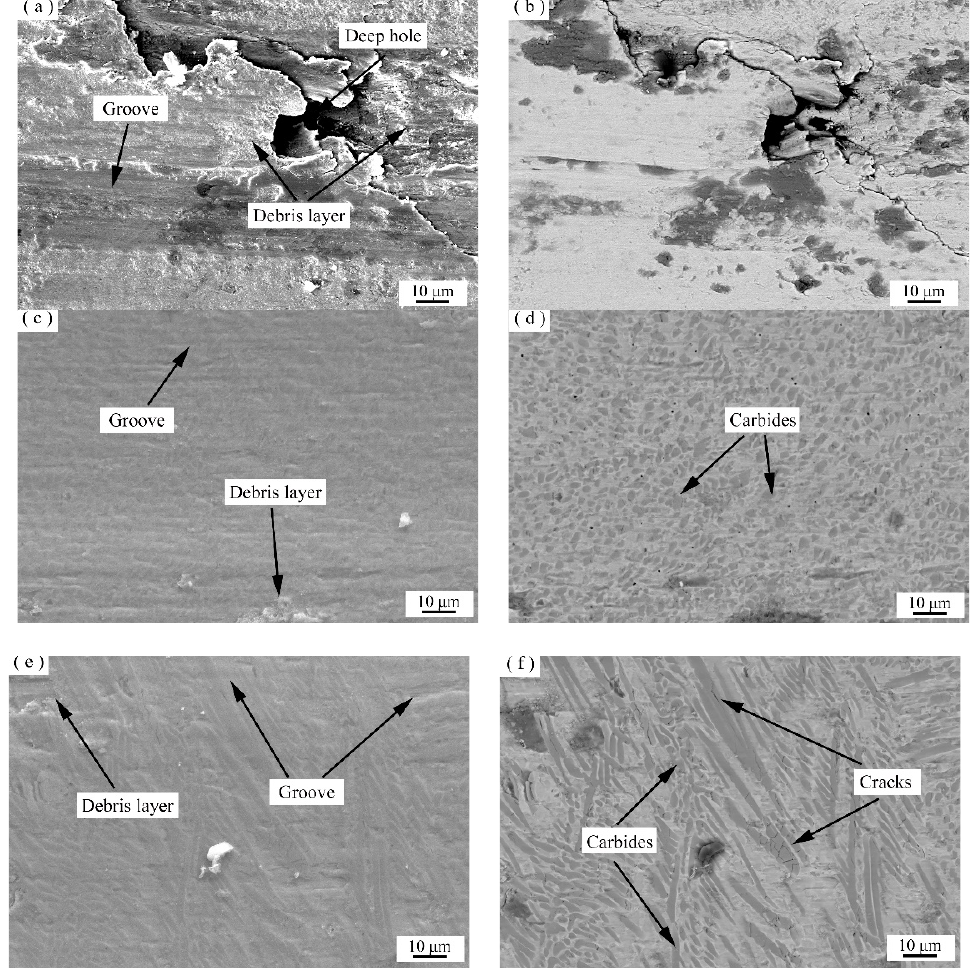
Figure 14. Secondary electron images ( a , c , e ) and backscattering electron images ( b , d , f ) of worn surfaces of vermicular cast iron, the alloyed powder cladding layer, and the mixed powder cladding layer, respectively.